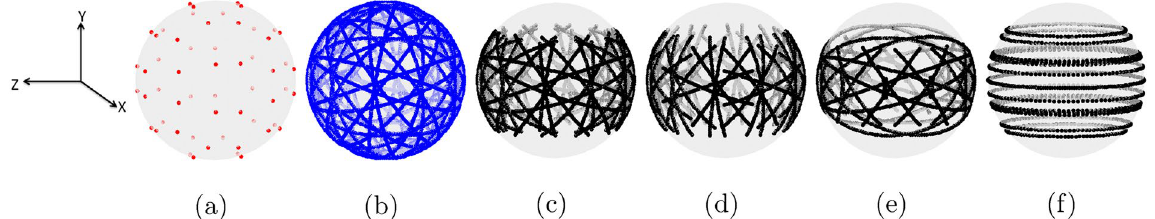
Figure 3. ( a ) A t-design with 56 uniformly distributed points. We aim to design trajectories that fully measure all of these scattering orientations. ( b ) Acquisition scheme Z ([0.7071, − 0.7071, 0] T , 100) with 2800 poses. Acquisition schemes ( c ) Z D (100) with 1676 poses, ( d ) Z H (100) with 1256 poses, ( e ) Z V (100) with 1284 poses, which measure all the points in ( a ) within the practical limitations of the setup with diagonally, horizontally and vertically aligned grating bars respectively. ( f ) acquisition scheme W (100).